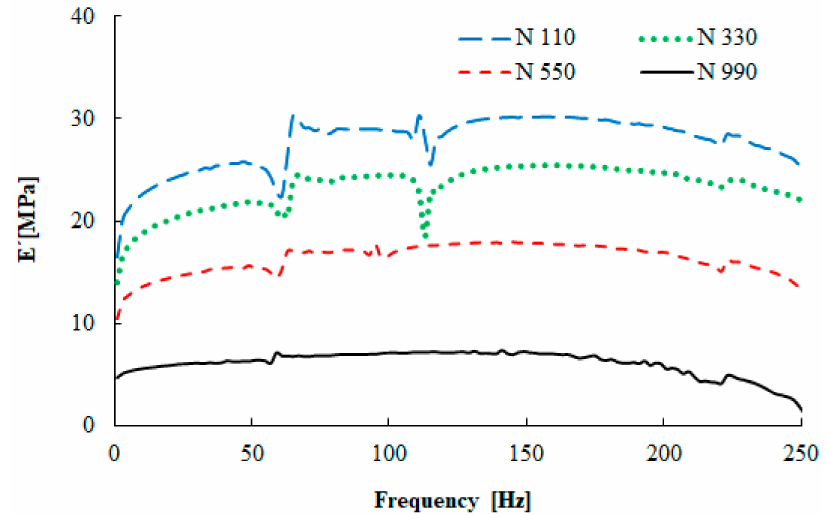
Figure 5. Frequency dependence of the tensile storage modulus (displacement x = 5 µ m, T = 25 ◦ C).